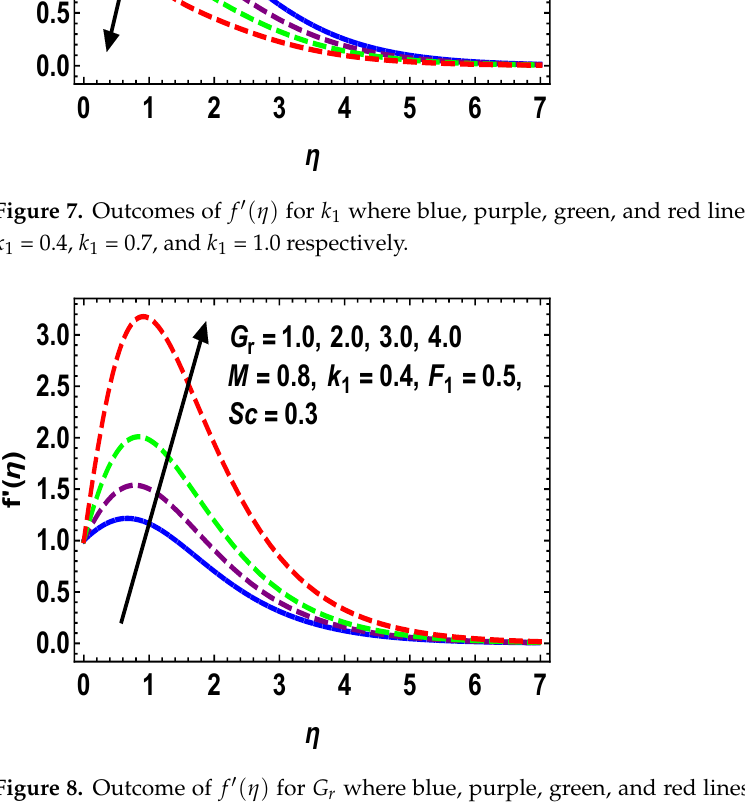
Figure 8. Outcome of f (cid:48) ( η ) for G r where blue, purple, green, and red lines represent for G r = 1.0, G r = 2.0, G r = 3.0, and G r = 4.0